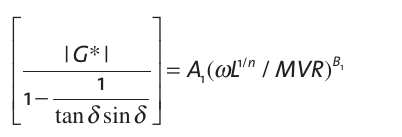
Figure 17a (left above): Plot of the shift factor L1/n/MVR predicted through Eq. 12a versus the experimental data for RTFOT-aged asphalts. Figure 17b (right above): Plot of the shift factor L1/n/MVR predicted through Eq. 12b versus the experimental data for PAV-aged asphalts. Figure 18 (left below): Com- parison of the predictions from calculations with experimental data for the new specification parame- ter |G*|/(1 - (1/tan d sin d )) versus frequency w at tem- perature of 70˚C for RTFOT- aged AAA-1 sample. Figure 19 (right below): Uni- fied curve of the new speci- fication parameter |G*|/(1 - (1/tan d sin d )) with modi- fied frequency w (L1/n /MVR) covering temperature range of 58˚C - 76˚C for Styrelf RTFOT-aged sample.